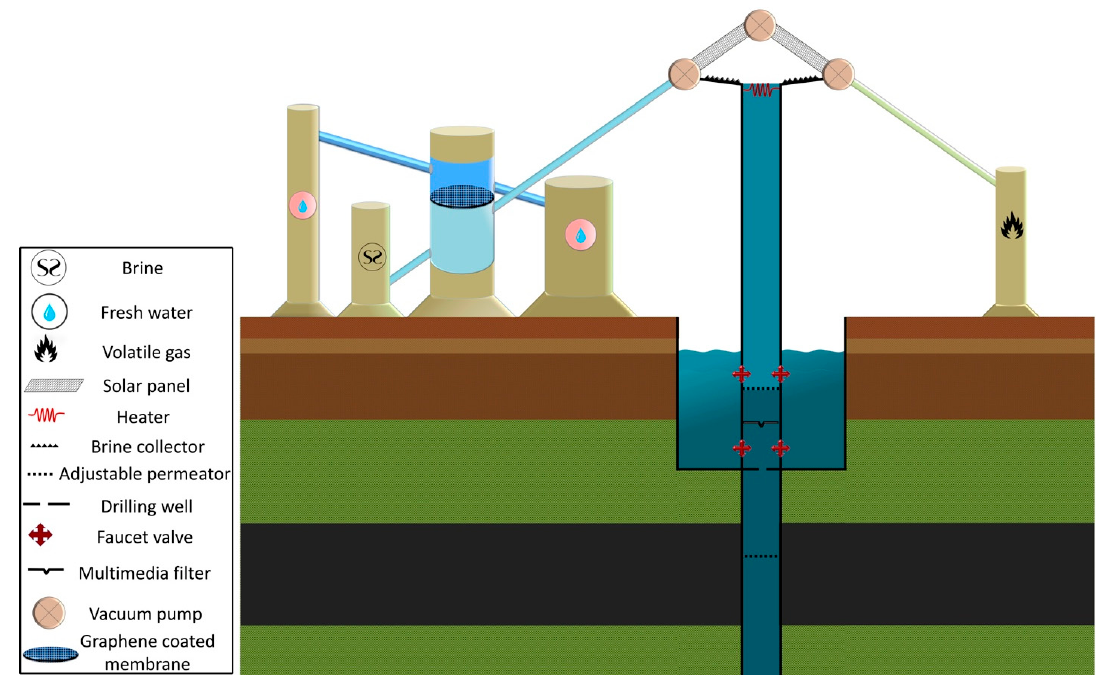
Figure 10. Schematic of the novel off-grid desalination plant, designed for off-grid treating of high salinity water in medium scale.